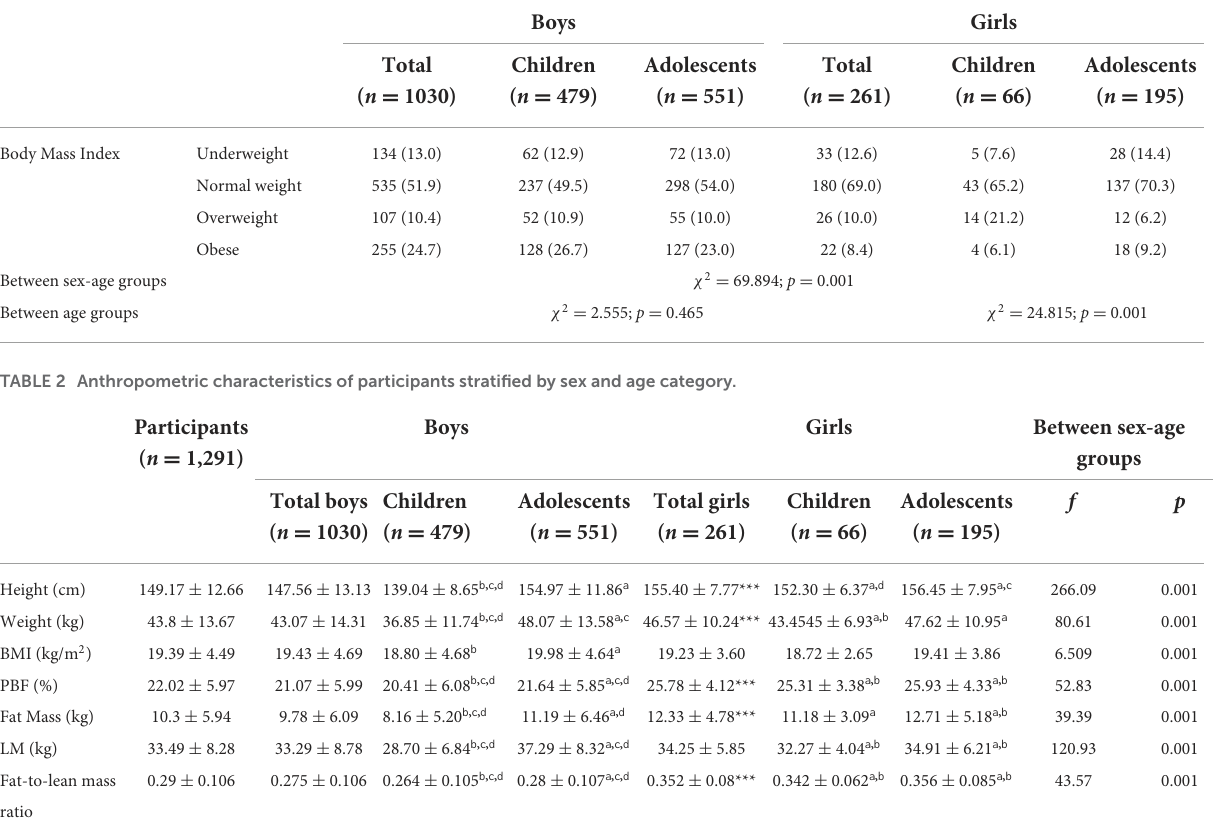
TABLE 1 Prevalence of underweight, normal weight, overweight, and obesity among participants stratified by sex and age category.